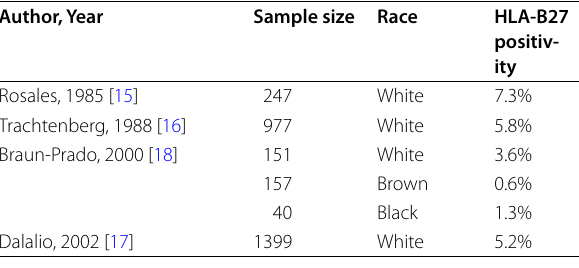
Table 1 Studies published with HLA-B27 positivity in Brazilian healthy population Author, Year